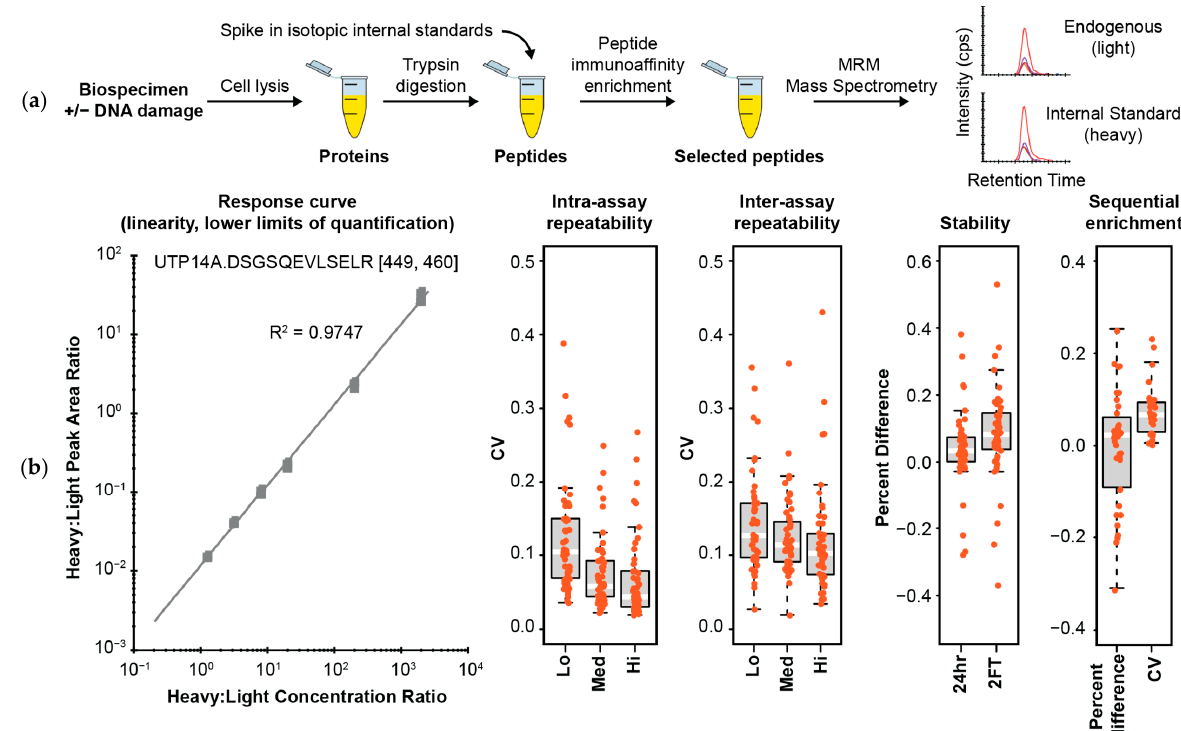
Figure 1. Immuno-MRM enables highly multiplexed protein quantification. ( a ) Assay workflow consists of generation of a protein lysate followed by enzymatic digestion (e.g., trypsin). Stable isotope labeled standards unique to each targeted peptide sequence are spiked to the sample at a known concentration. Custom monoclonal antibodies coupled to magnetic beads are used to enrich the endogenous peptides and labeled standards. The eluate is analyzed by multiple reaction monitoring mass spectrometry, where analyte peptides and internal standards coelute with equivalent relative areas of monitored transitions. High specificity is maintained through optimal selection of fragment ion transitions to monitor. ( b ) Characterization of performance figures of merit of the assay. A representative response curve for the heavy peptide DSGSQEVLSELR spiked into cell lysate shows a typical linear range. Repeatability is characterized by the distribution of CV values for intra- (within day) and inter- (between day) assay repeatability. Each point corresponds to the average CV for a peptide measured at three concentrations, Low (Lo), Medium (Med), and High (Hi) in triplicate over five days (n = 15 at each concentration for a peptide). Stability shows the distribution of percent difference for samples stored at 24 h at 4 ◦ C and after two freeze-thaw cycles relative to immediate analysis. Sequential enrichment shows the distribution of percent difference and CV values following enrichment using the flow-through of a sample from another immuno-MRM assay compared to direct enrichment. For box plots, the white line shows the median value, boxes show the inner quartiles, and the whiskers show 5–95% of